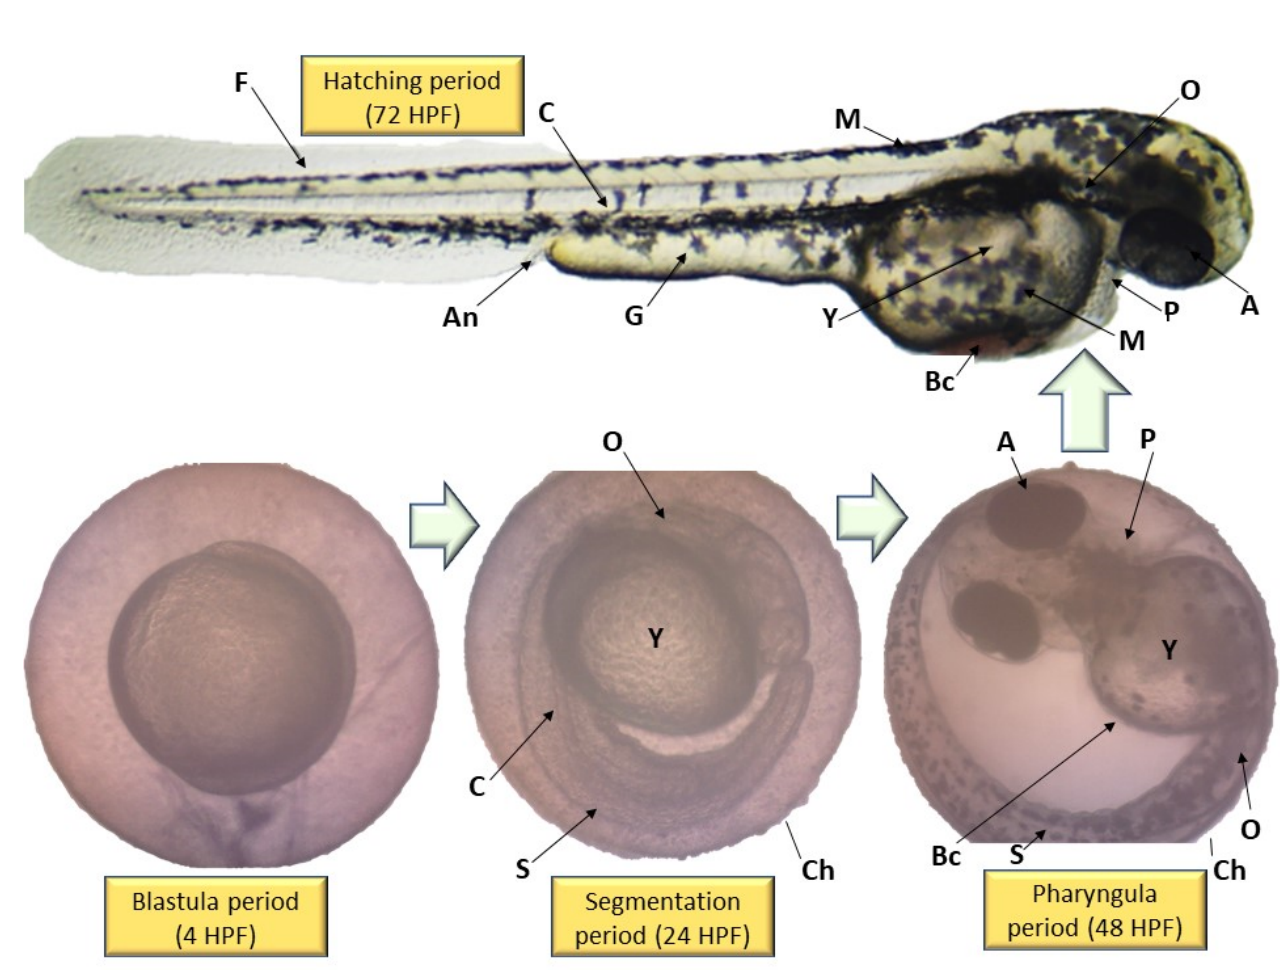
Figure 5. Effect of EPS-ENS extracts (0.01–1 mg/mL) of European Ganoderma applanatum showing normal zebrafish embryogenesis at different HPF development. The inverted microscope was used to produce the images and edited using paint 3D [11]. There were 4 periods depicted: Blastula (4 HPF), Segmentation (24 HPF), Pharyngula (48 HPF), and Hatching